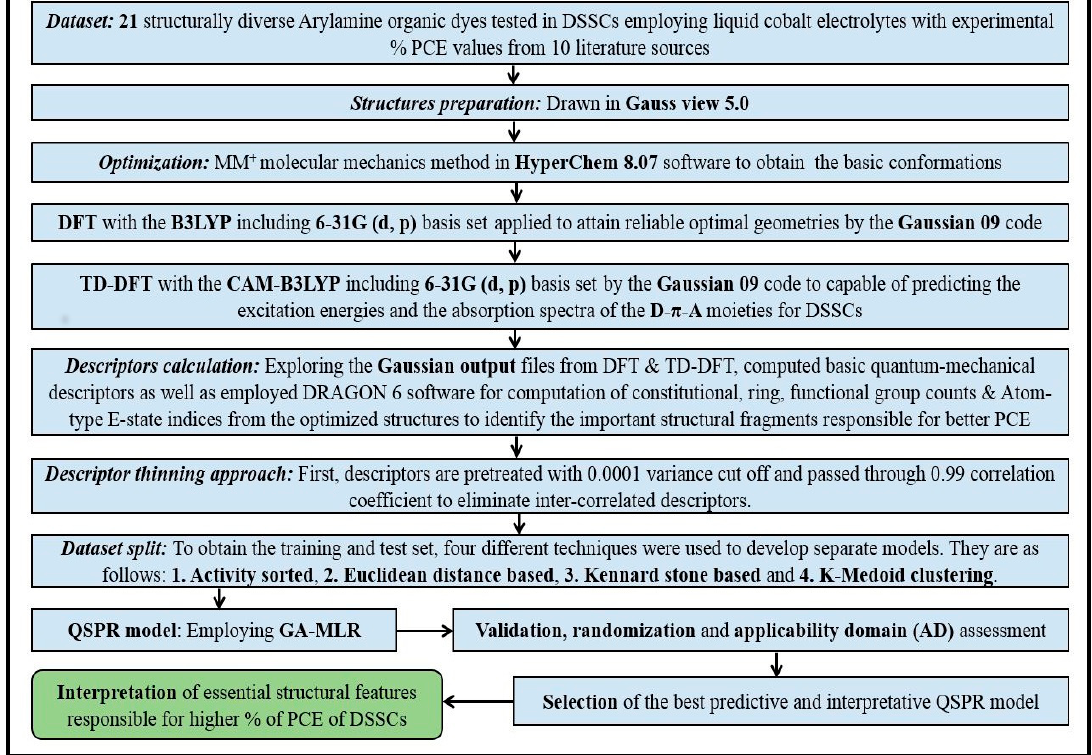
Figure 1. A complete scheme of the present study.